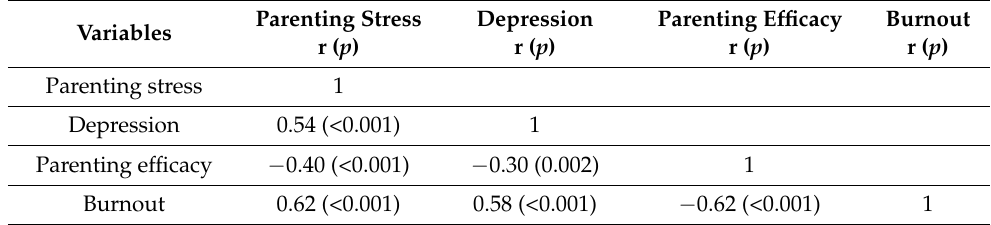
Table 3. Correlations among the